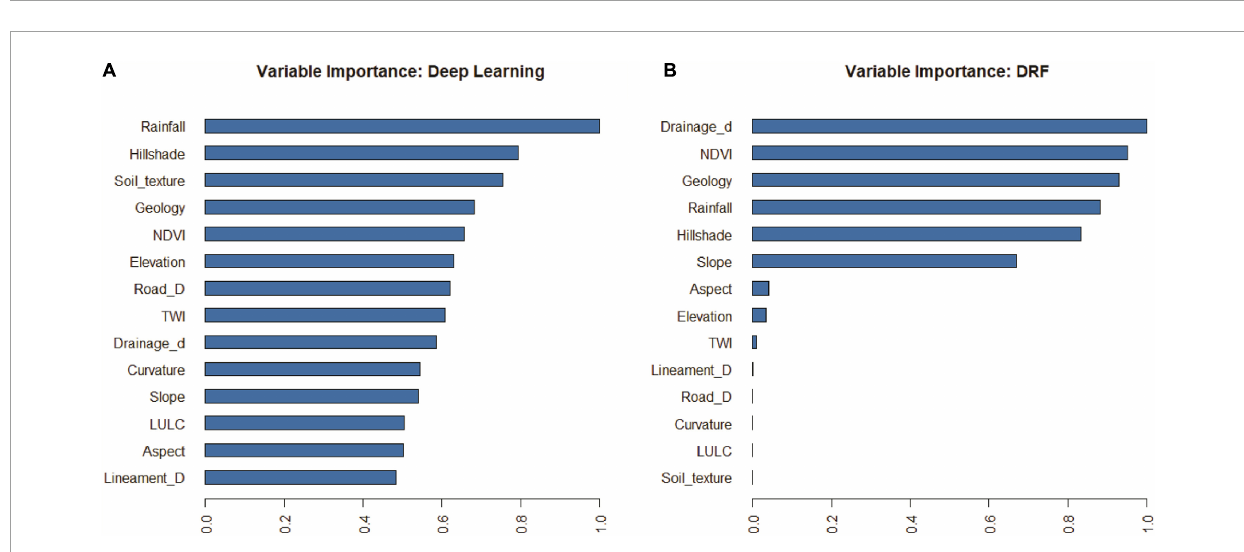
FIGURE10 Computation of important parameter for predicting LSM using best (A) DNN, and (B) RF